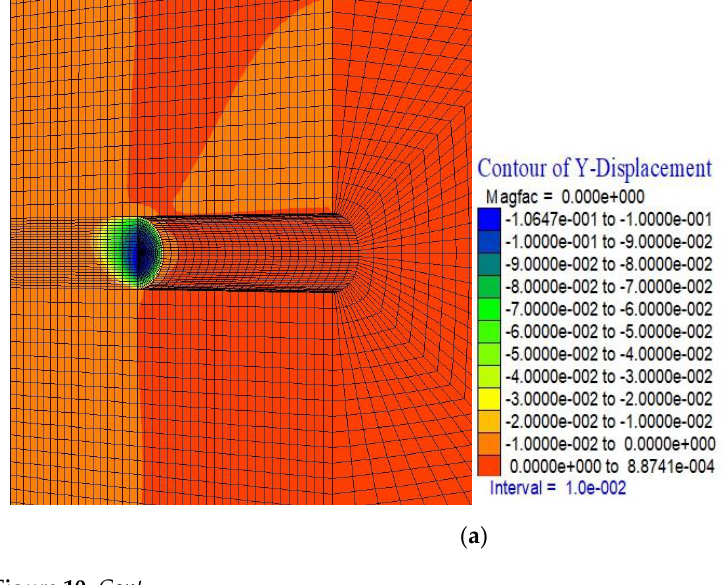
Table 3. Rock mass parameters employed during the back